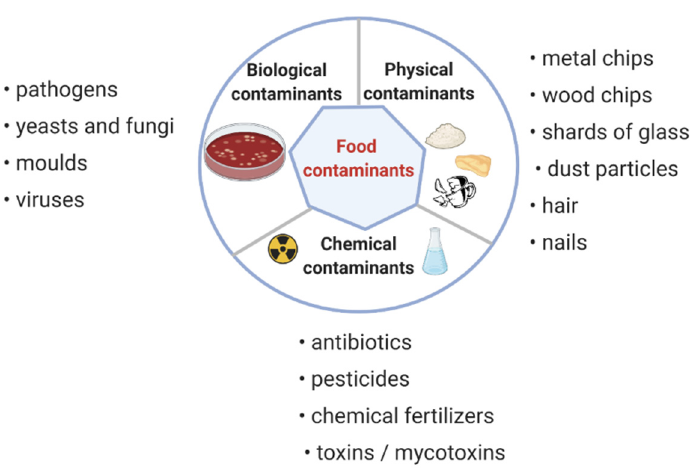
Figure 2. Contaminations in the food.